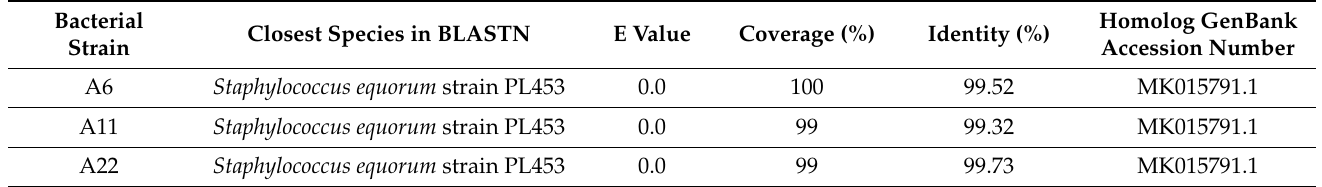
Table 1. Phylogenetic identification of ureolytic bacterial strains isolated from tailings.